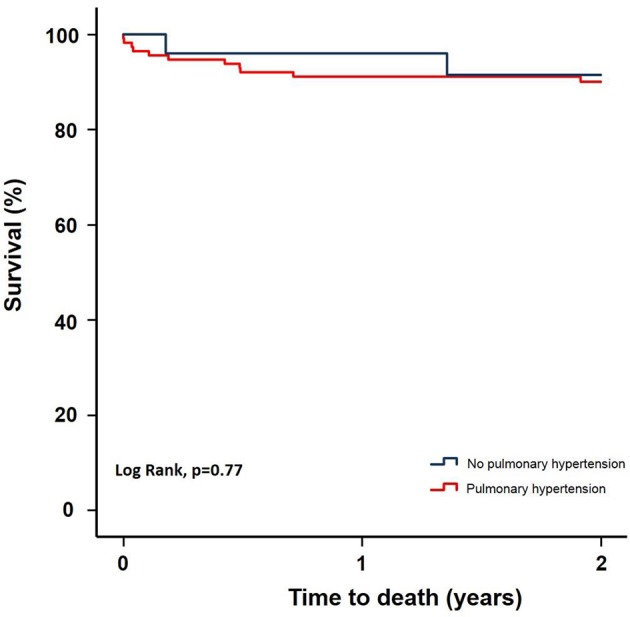
Kaplan-Meier survival curve for patients with and without PH.